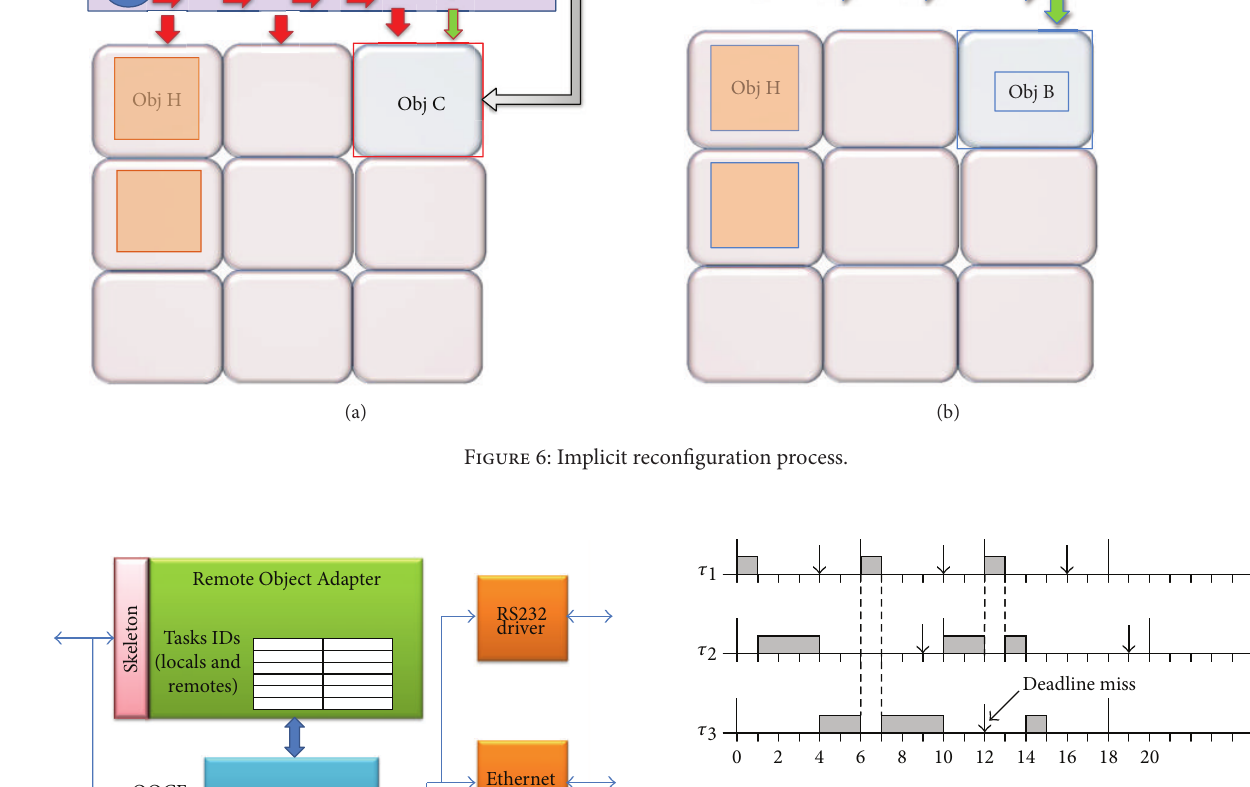
Figure 8: Schedule produced by Deadline Monotonic in fully preemptive